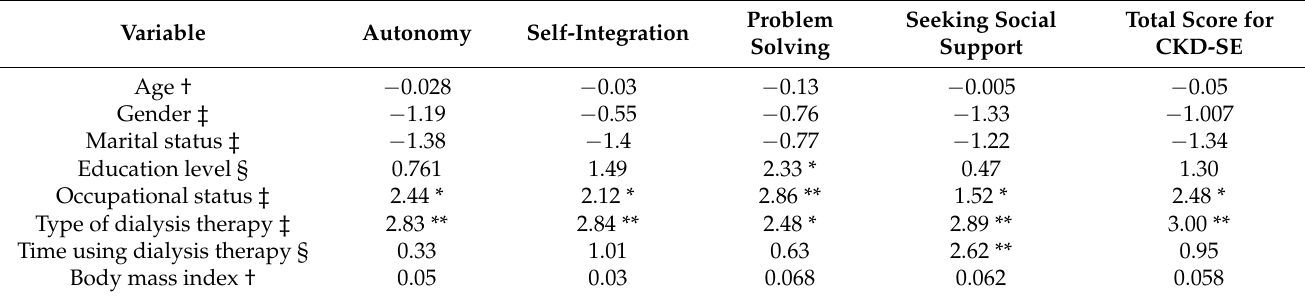
Table 3. Correlation between Perceived Self-efficacy and sample